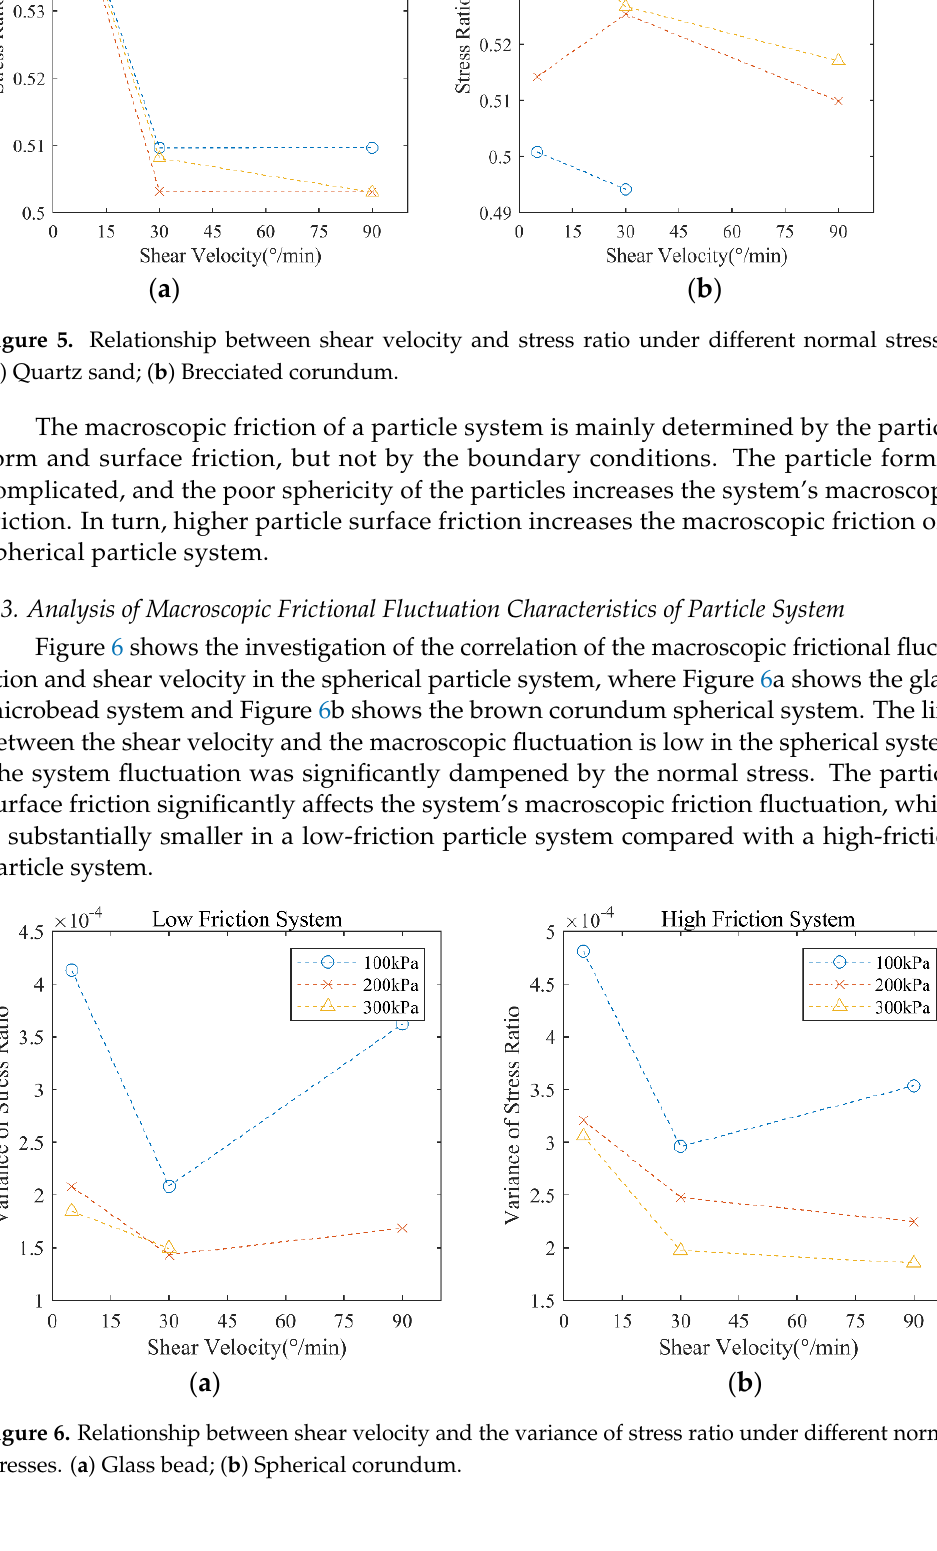
( b ) Figure 7. Relationship between shear velocity and the variance of stress ratio under different normal stresses. ( a ) Quartz sand; ( b ) Brecciated corundum.